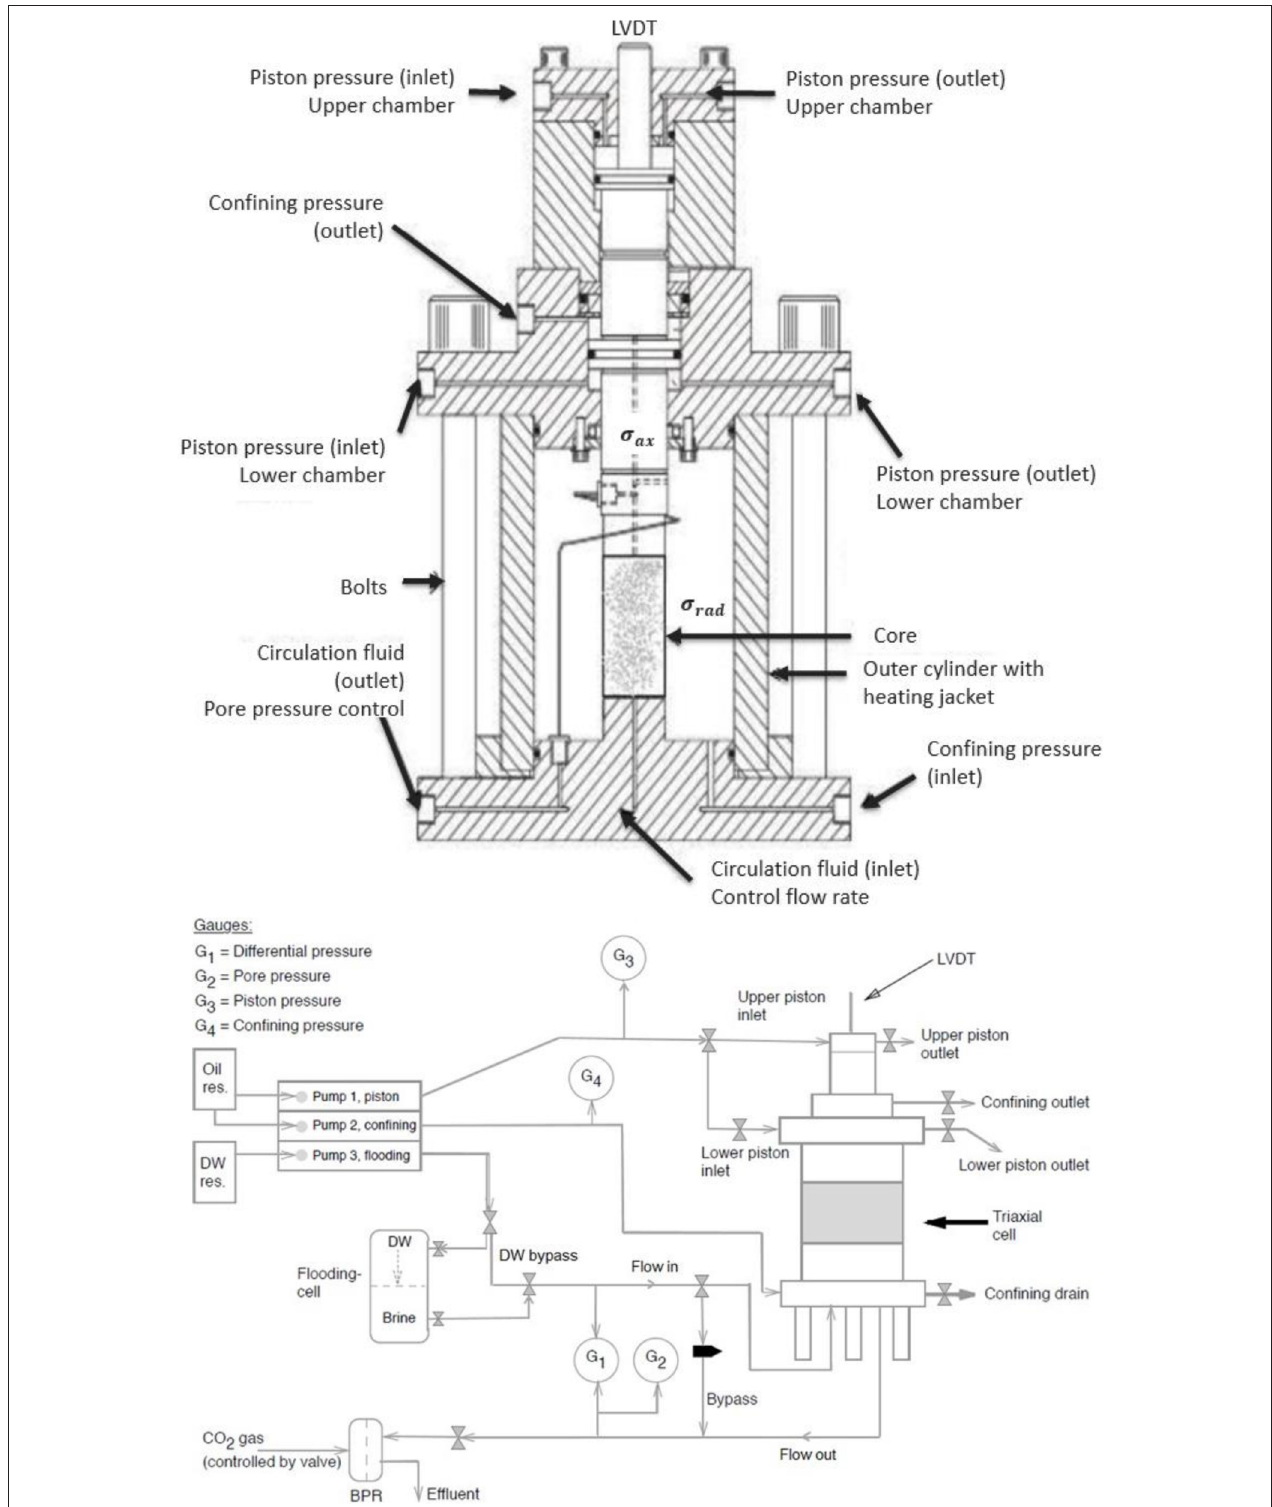
FIGURE 1 | (Top) Sketch of the tri-axial cell [17] and an overview of the gauges, pumps and flow-loop in the experimental setup (Bottom).